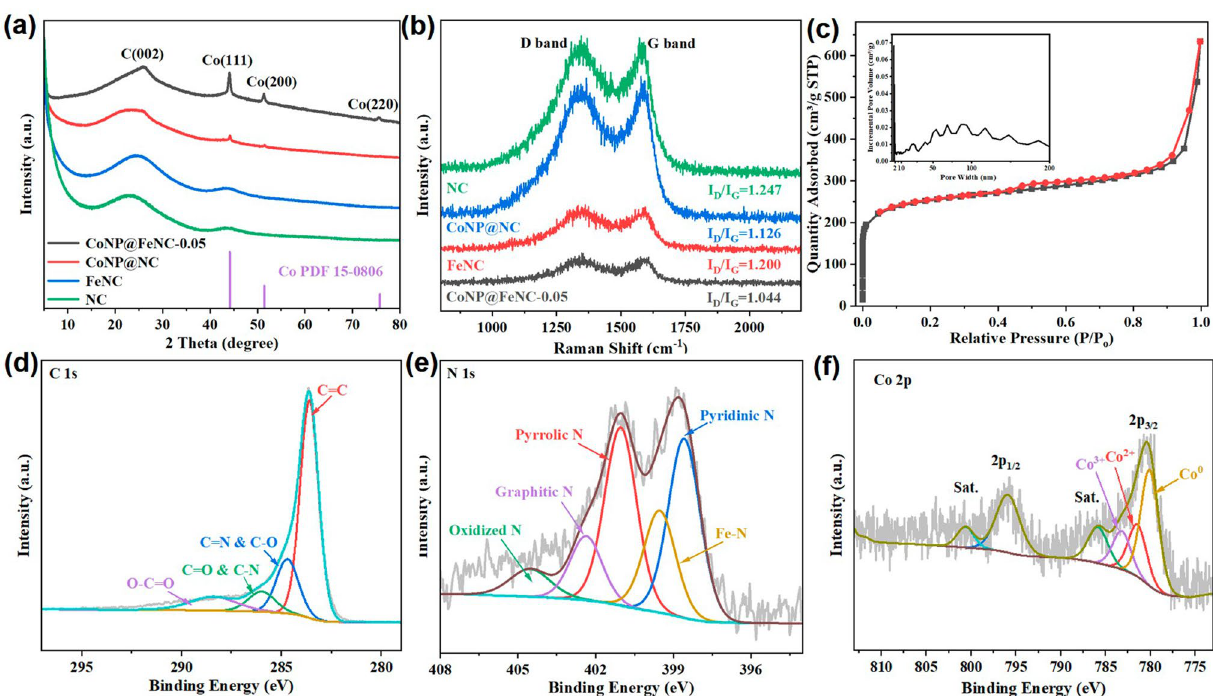
Fig. 3 a XRD patterns of CoNP@FeNC-0.05, FeNC, CoNP@NC and NC. b Raman spectra of prepared catalysts. c N 2 adsorption-desorption isotherm curve and pore size distribution of CoNP@FeNC-0.05. d High-resolution C 1 s XPS of CoNP@FeNC-0.05. e High-resolution N 1 s XPS of CoNP@FeNC-0.05. f High-resolution Co 2 p XPS of